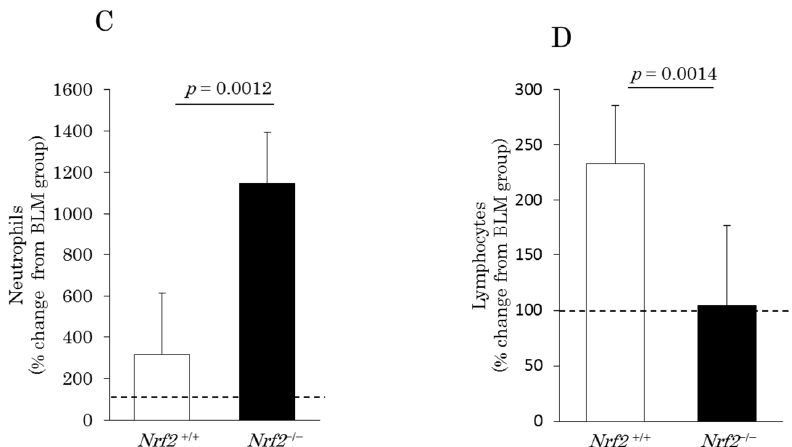
Figure 1. Differential cell counts in the bronchoalveolar lavage fluid (BALF) on day 10 after bleomycin (BLM) injection and after exposure to diesel exhaust (DE) for 38 days. The vertical axis shows percentage changes in the cell numbers of the DE plus BLM group relative to the BLM group. ( A ) total cells; ( B ) macrophages; ( C ) neutrophils; ( D ) lymphocytes. Data are shown as mean ± standard deviation (SD) values in each group ( n = 5). NS: no significant difference.